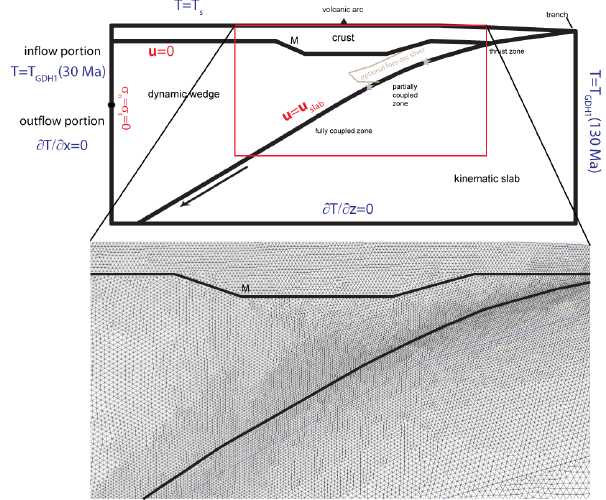
Fig. 3. General model geometry (top) and partial mesh (bottom) used in the finite element modeling. The velocity is prescribed in the slab and set to zero in the crust of the overriding plate (with the Moho indicated by M). The wedge is modeled as a fluid with a rheology appropriate for dry olivine (as in van Keken et al., 2008). The wedge flow is driven by coupling with the slab. As in Syracuse et al. (2010) and Wada and Wang (2009) we assume in general that this depth is 80km. Between the down-dip limit of the earthquake thrust zone (bold red line in Fig. 1) and 80km depth we assume partial coupling. The governing equations are discretized on a finite element mesh with a finest resolution of 1km along the slab surface and in the crust. The Stokes equations are solved in the dynamic wedge only, with boundary conditions indicated in red. The heat equation is solved on the entire domain, with boundary conditions indicated in blue. In one particular case we assume the presence of a subducted fore-arc sliver as indicated by the grey lines. T s is surface temperature (assumed to be 293K here), T GDH1 is the tem- perature of the half-space cooling model of Stein and Stein (1992). u is velocity, σ n is normal stress, σ t is tangential stress, u slab is the imposed slab